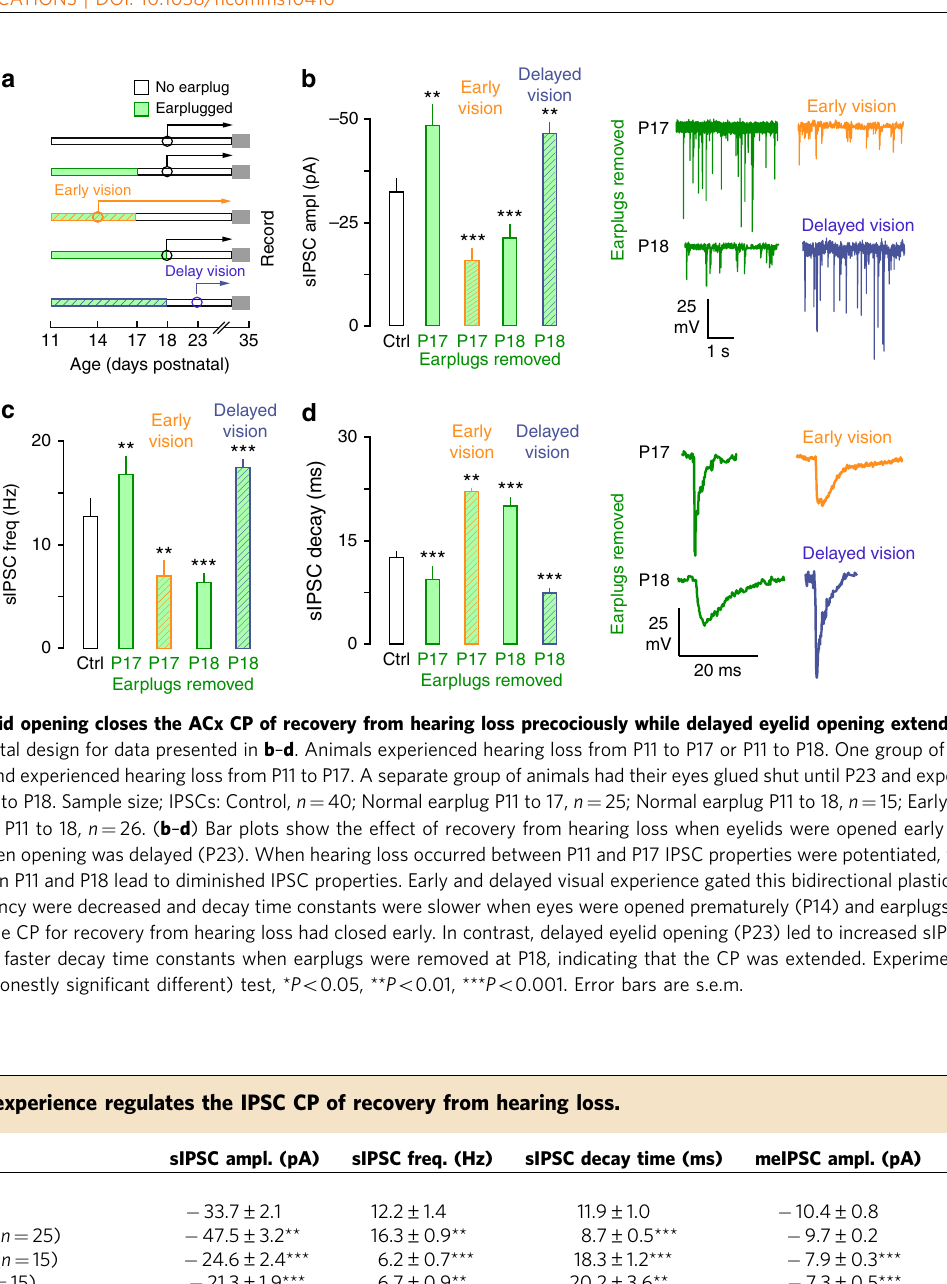
Figure 6 Adult Ctrl, ( n ¼